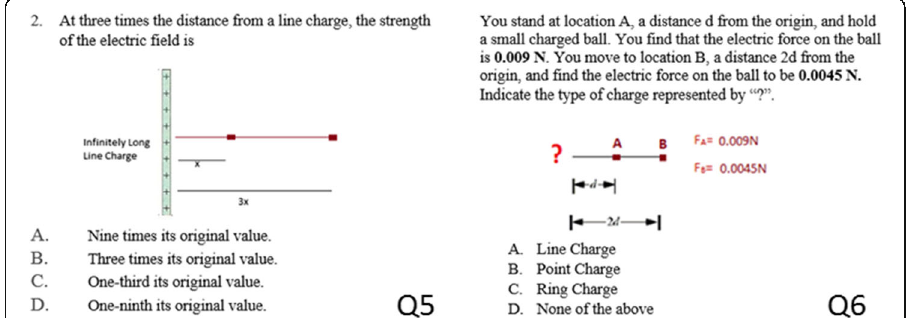
Fig. 5 Questions for infinitely long charge configuration. Q5 Source: Question developed by the researchers. Q6 Source: